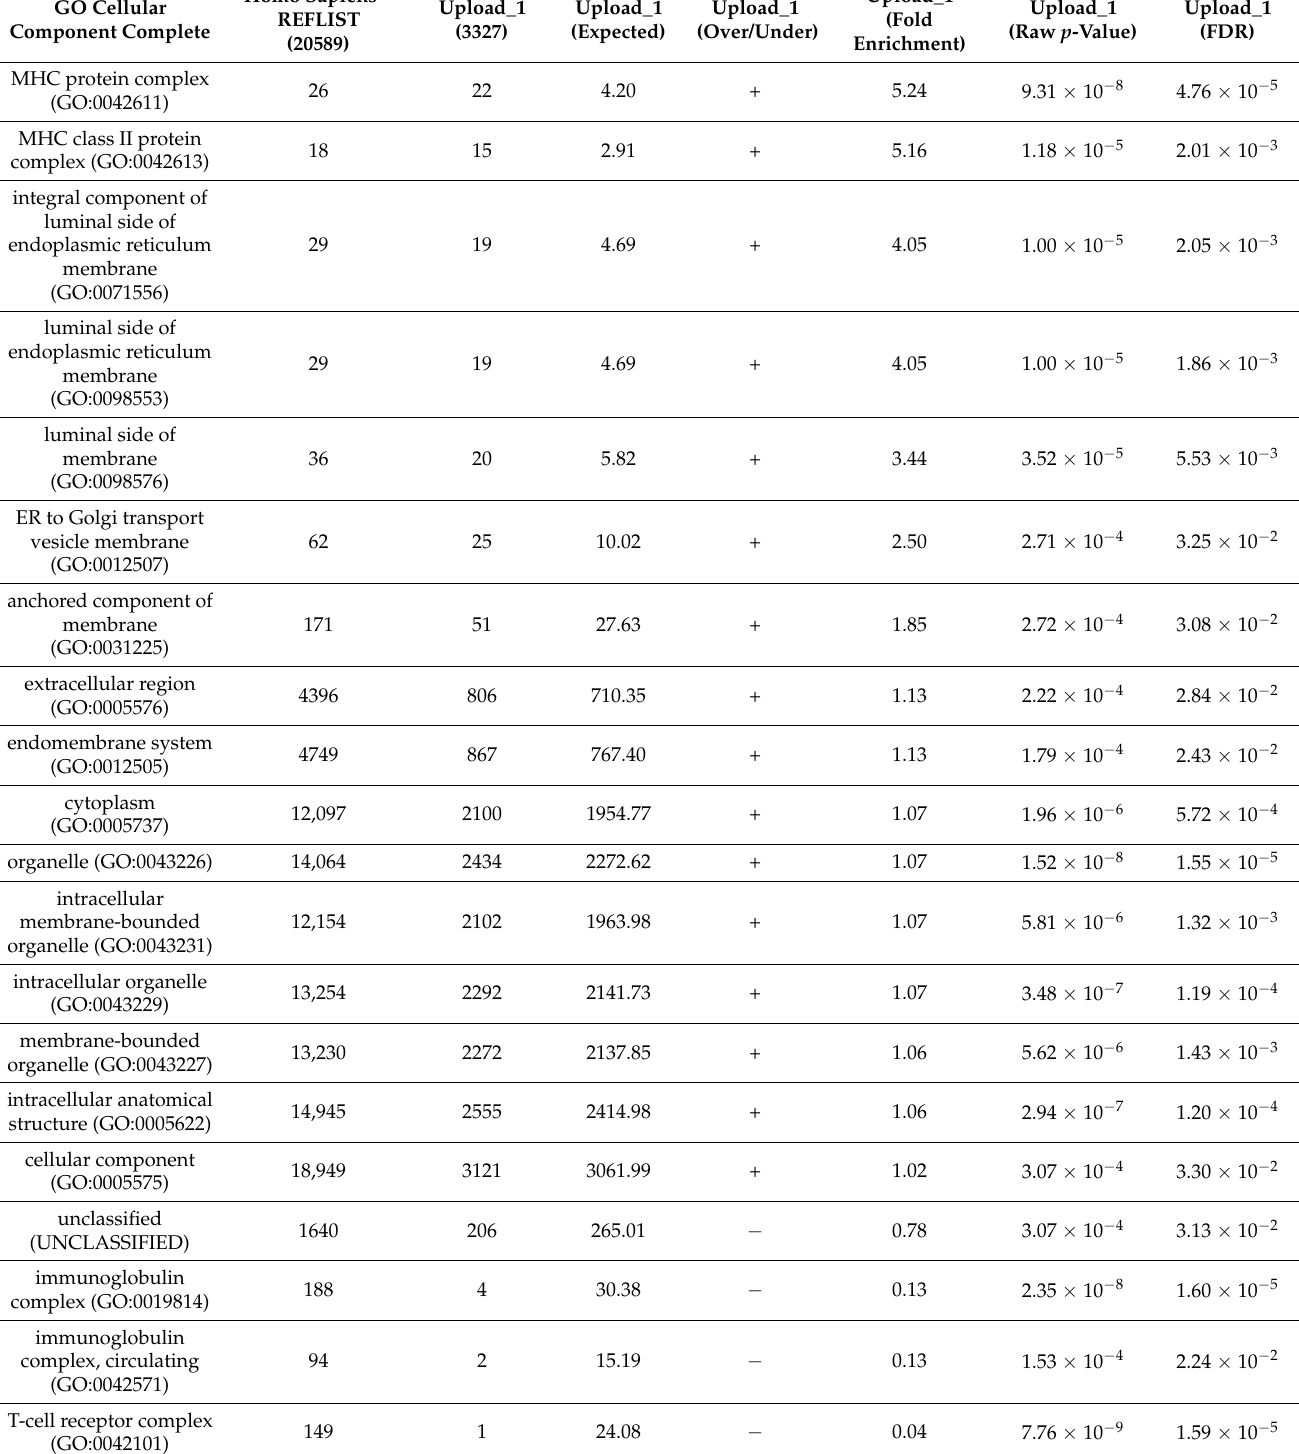
Table 4. GO cellular components in 122 CRC patients with CNAs in B2M